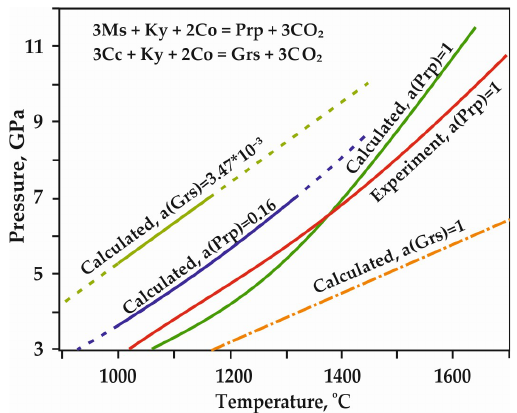
Figure 4. P,T diagram with previously experimentally constrained and calculated decarbonation curves,